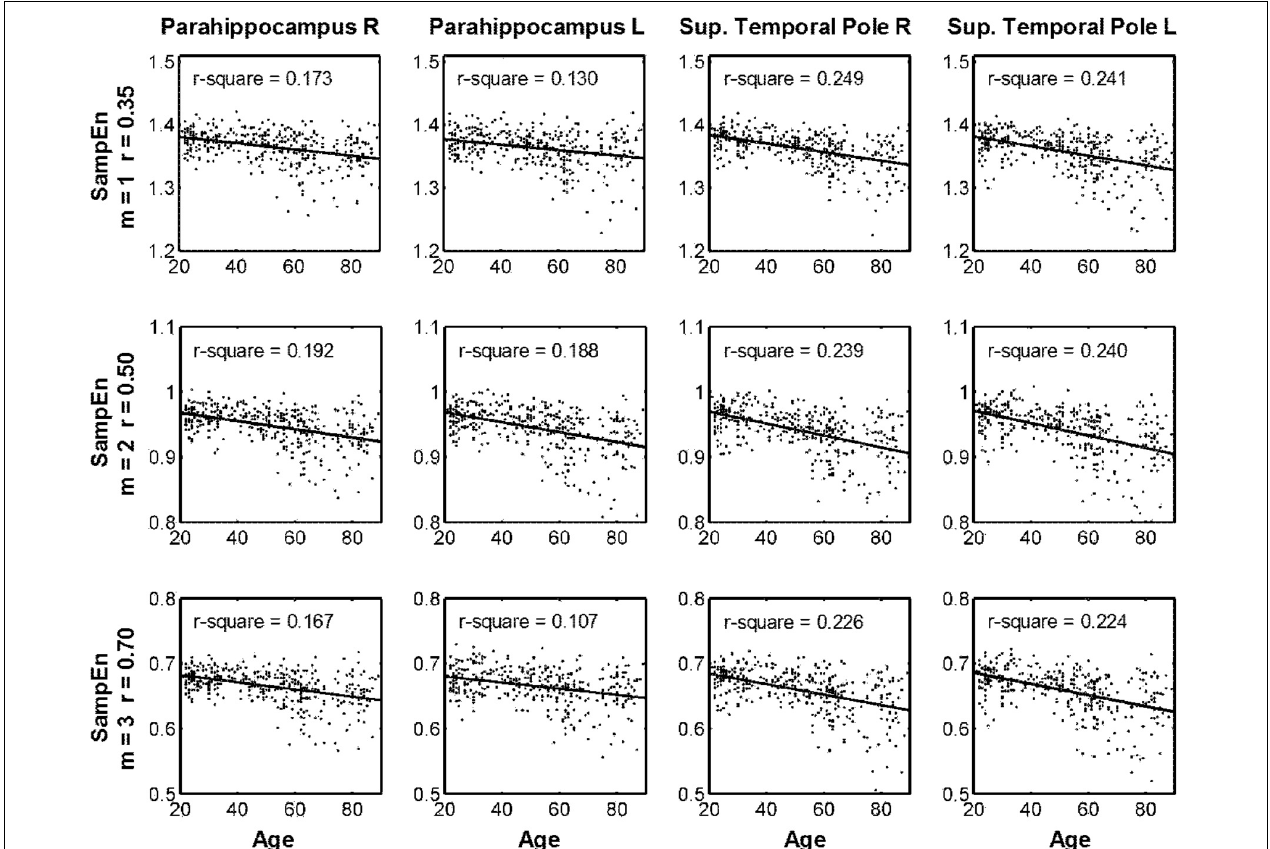
FIGURE 6 | Scattered plots of correlation between age and multiscale entropy (MSE) based on the average sample entropy (SampEn) with various parameters calculated in the four brain regions identified in Table 2